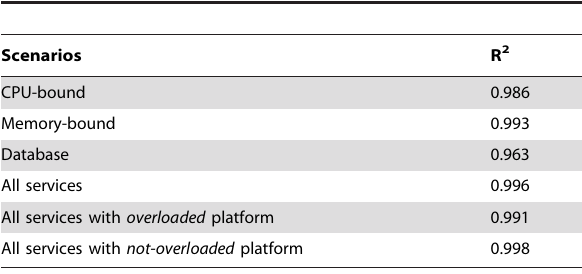
Table 3. Coefficient of determination (R 2 ) obtained from the stepwise-AIC method.